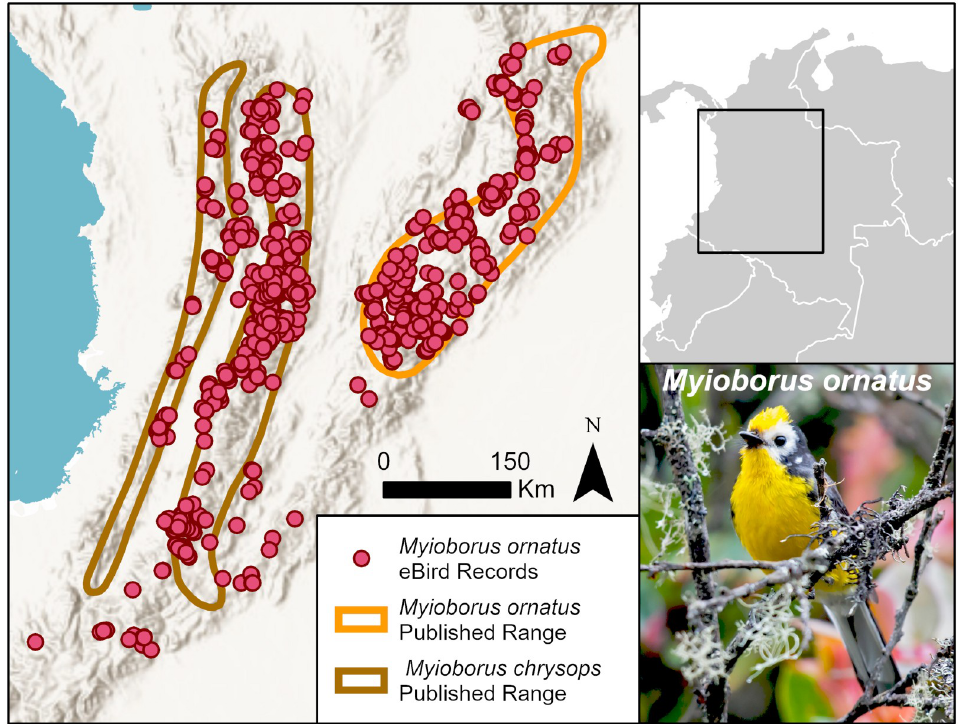
Fig 9. eBird observations of the Myioborus ornatus superspecies. eBird considers Myioborus ornatus to be one species, but [1] treat it as two separate species: Myioborus ornatus in the Eastern Andes (orange polygon) and Myioborus chrysops in the Central and Western Andes (brown polygon). Basemap provided by USGS and photo provided by Juan Jose´ Arango with permission.